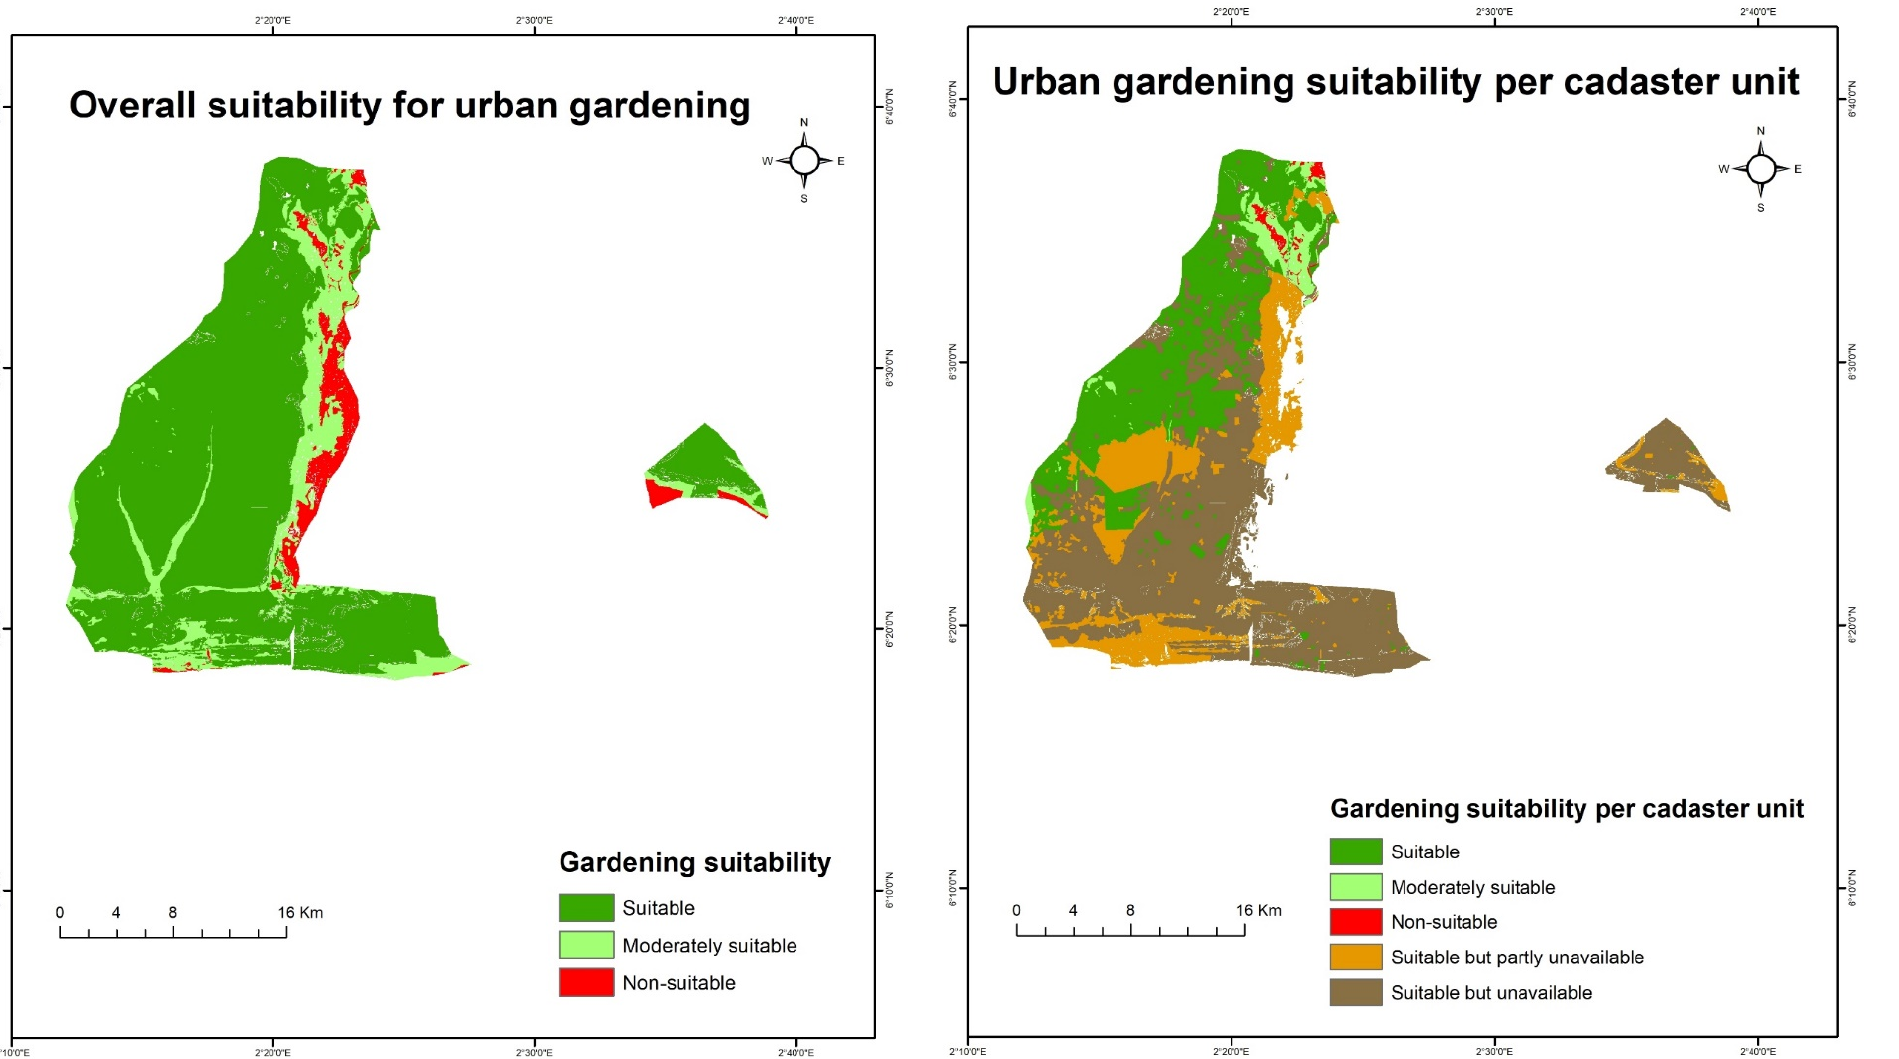
Figure 3. Classified maps of suitable areas for urban agriculture: baseline scenario.